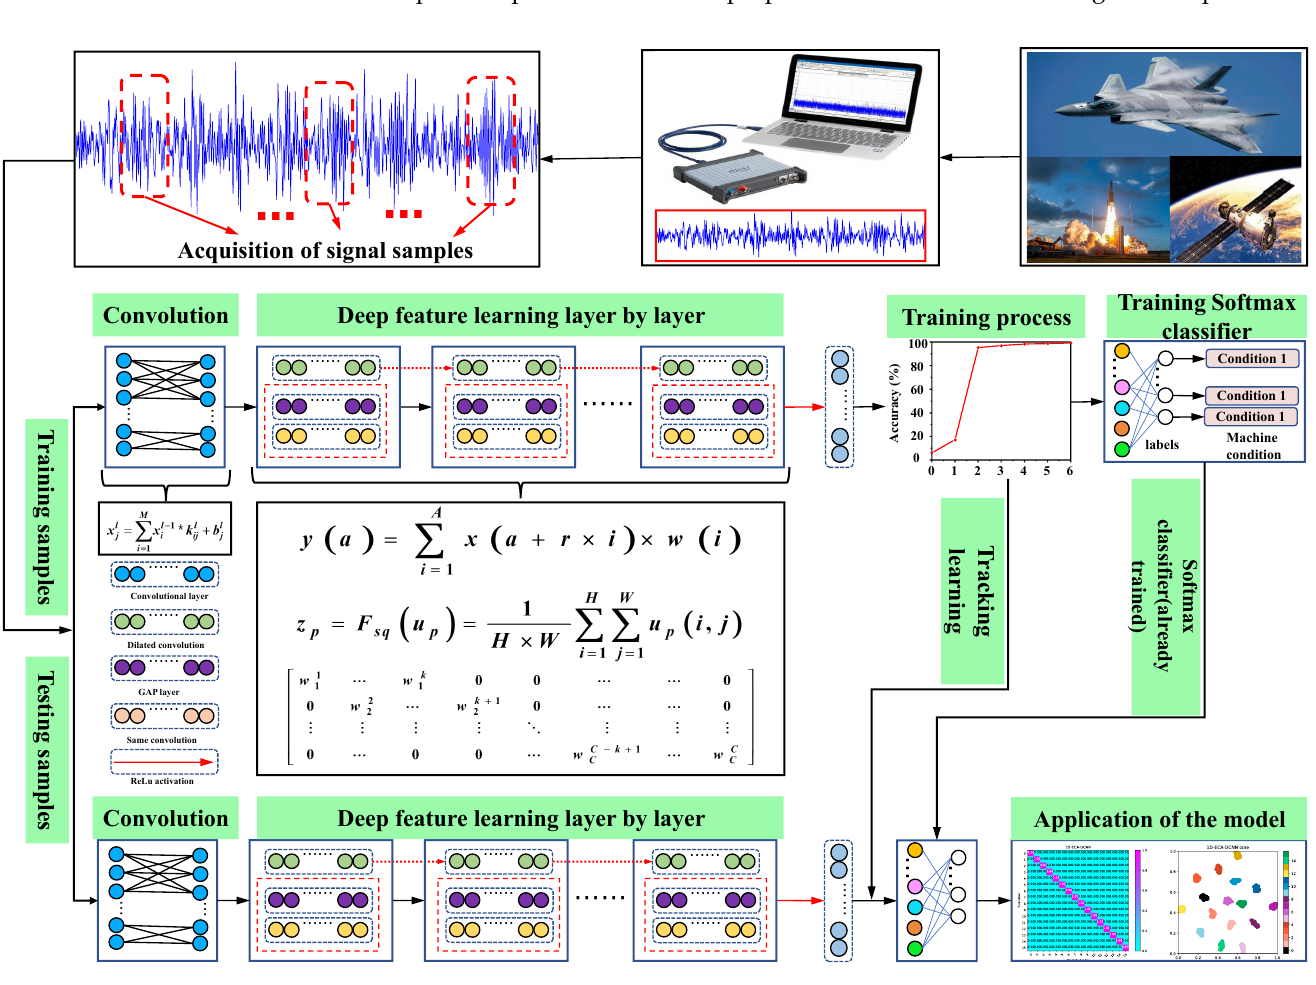
Figure 5. The structure of intelligent fault